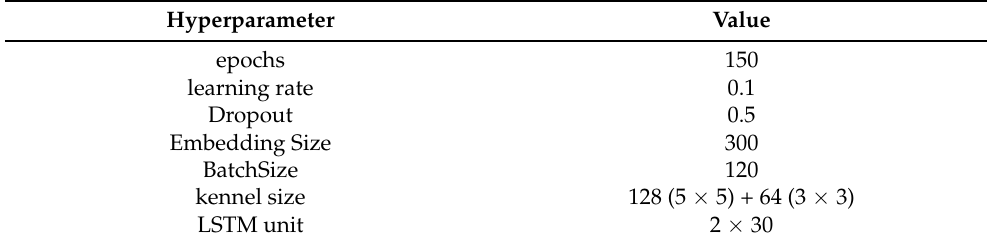
Table 6. The parameter setting of the